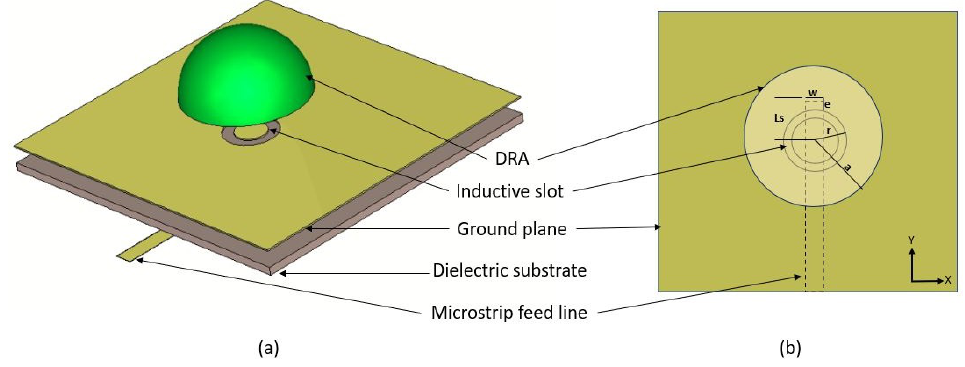
Figure 1. A slot-fed hemispherical DRA configuration ( a ) 3D view ( b ) 2-D top